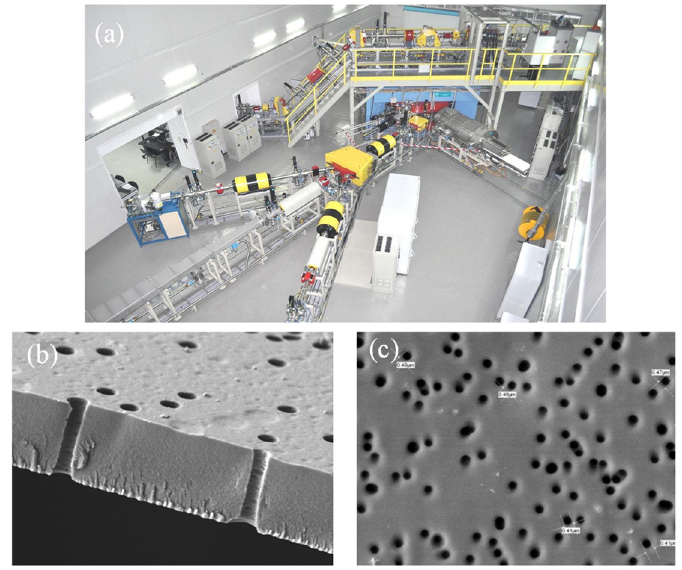
Figure 3. DC-60 cyclotron complex ( a ); SEM image of cross-sectional view of the membrane ( b ); SEM image of PET TeM surface ( c ).